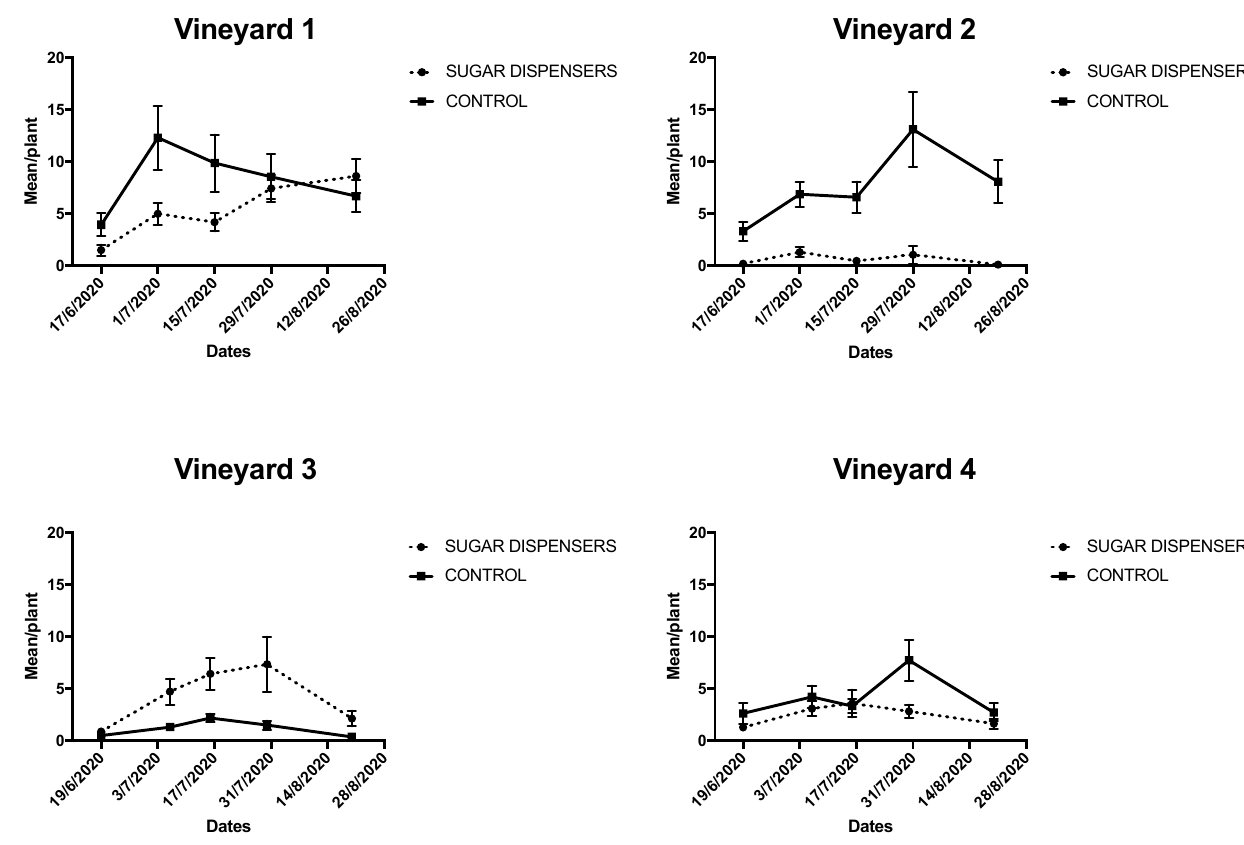
Figure 5. Ant activity ( ± SE) in sugar dispenser and control plots in each vineyard. Ant activity was estimated by counting the number of ants crossing an imaginary line on vine trunk in 1-minute period.